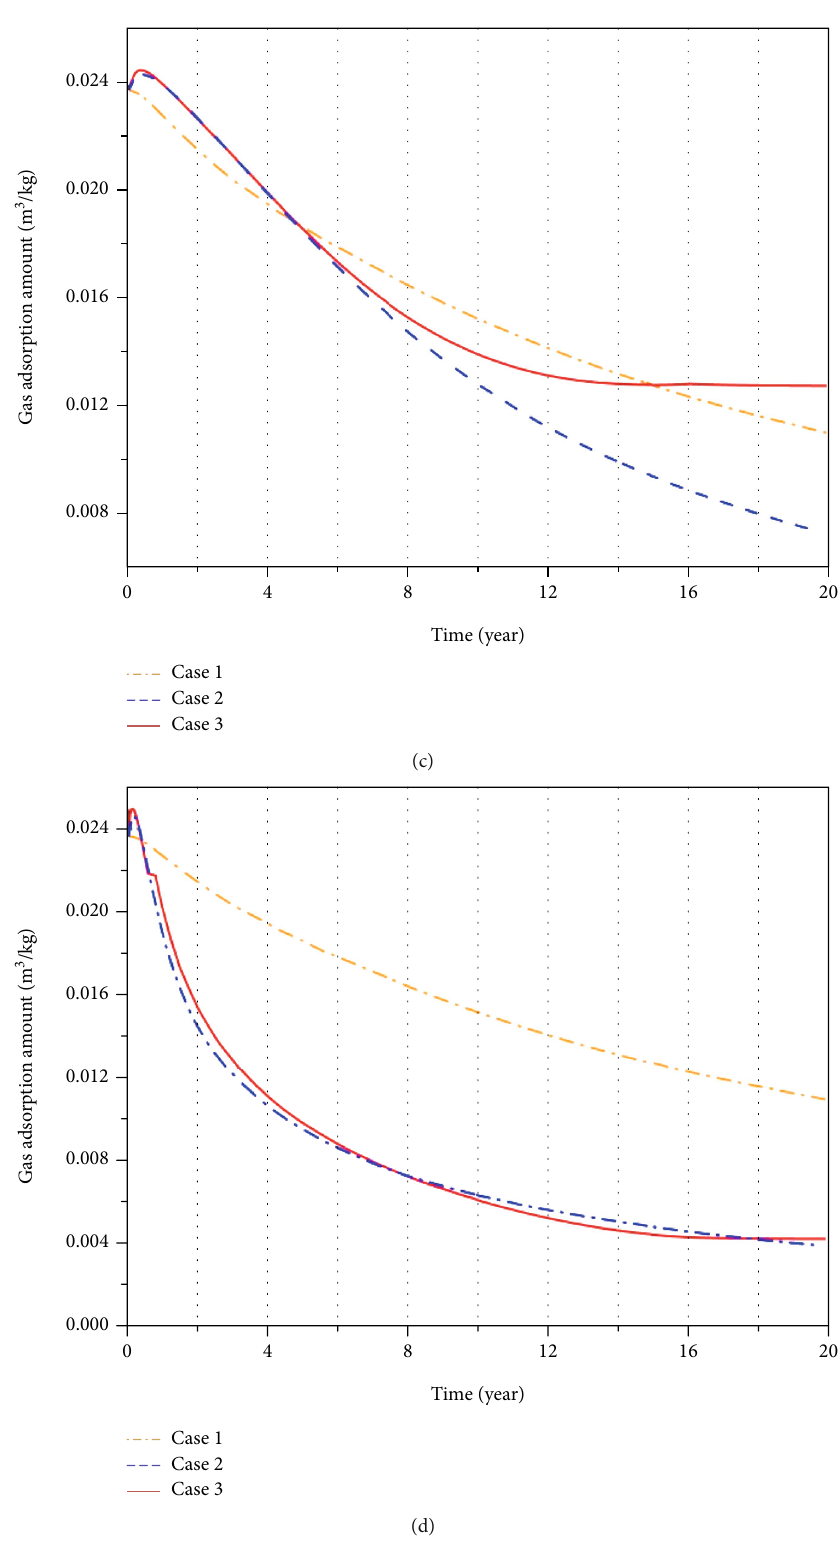
Figure 12: The temporal evolution of gas adsorption amount for three di ff erent cases at (a) MP1, (b) MP2, (c) MP3, and (d)